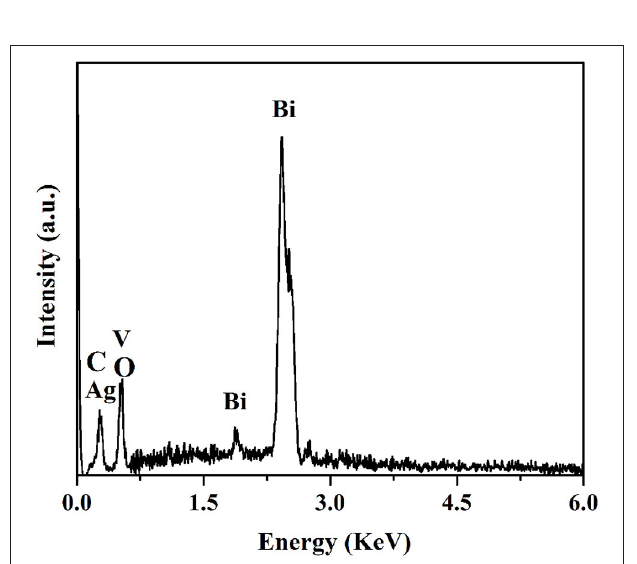
FIGURE 3 | EDS spectra of AVO/BOC-10.